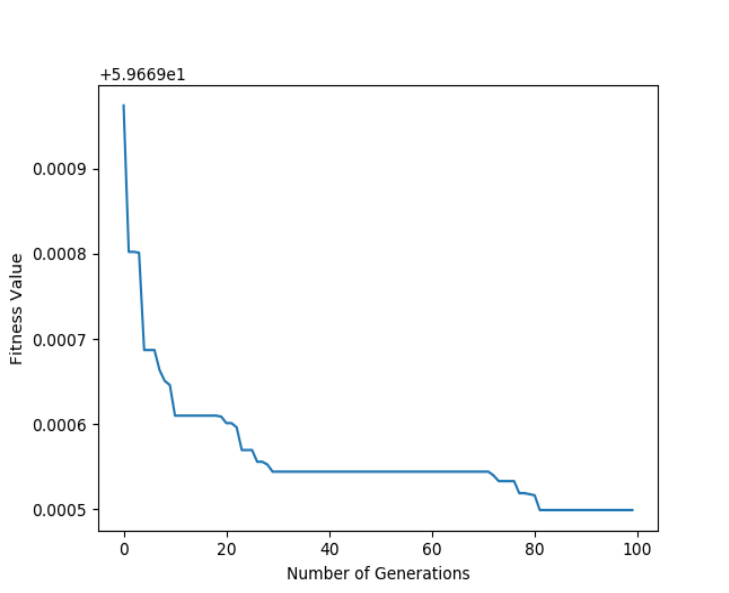
Figure 6. Convergence graph for